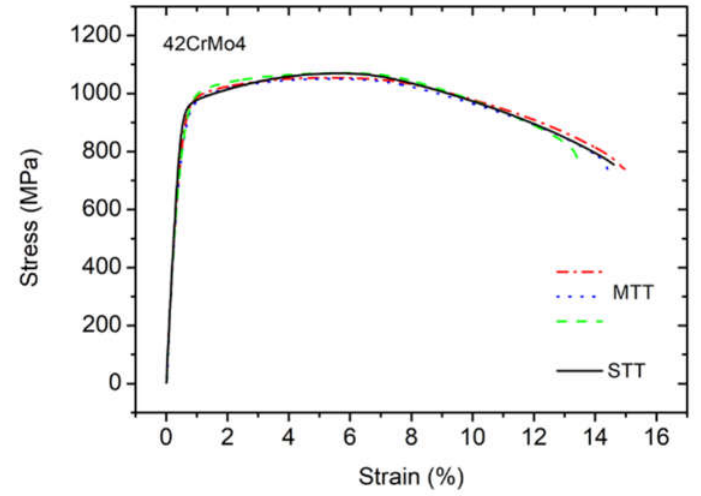
Figure 2. Tensile test results for standard tensile (STT: solid line) and mini-tensile tests (MTT: discontinuous lines).